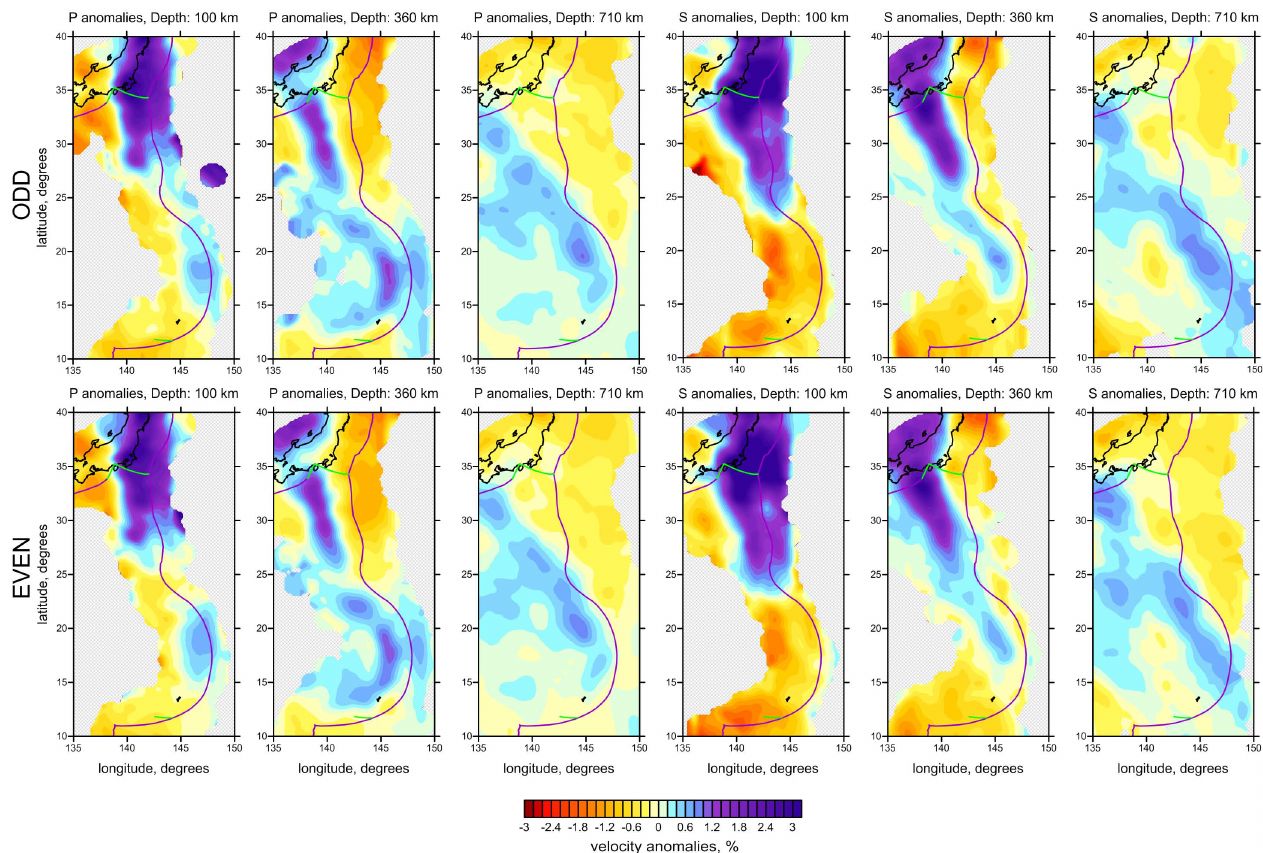
Fig. 6. Test with even and odd numbers of sources to estimate the level of random noise. The distribution of P- and S-anomalies are shown at different depths. The upper and lower rows correspond to results with odd and even numbers of sources,